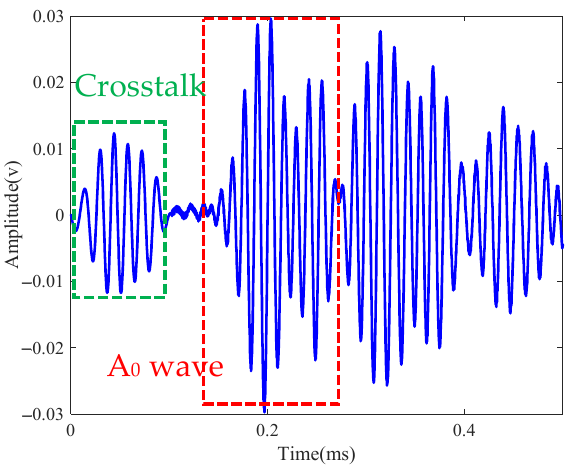
Figure 22. Scattered signal of two-damage case.